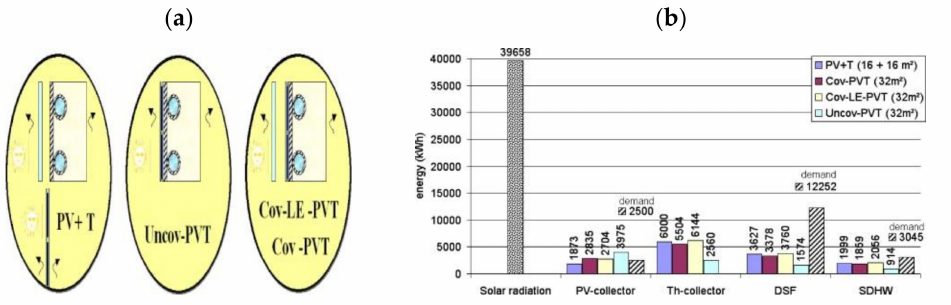
Figure 9. ( a ) Four different configurations; ( b ) annual energy performance for four configurations (reprinted from [76], with permission from